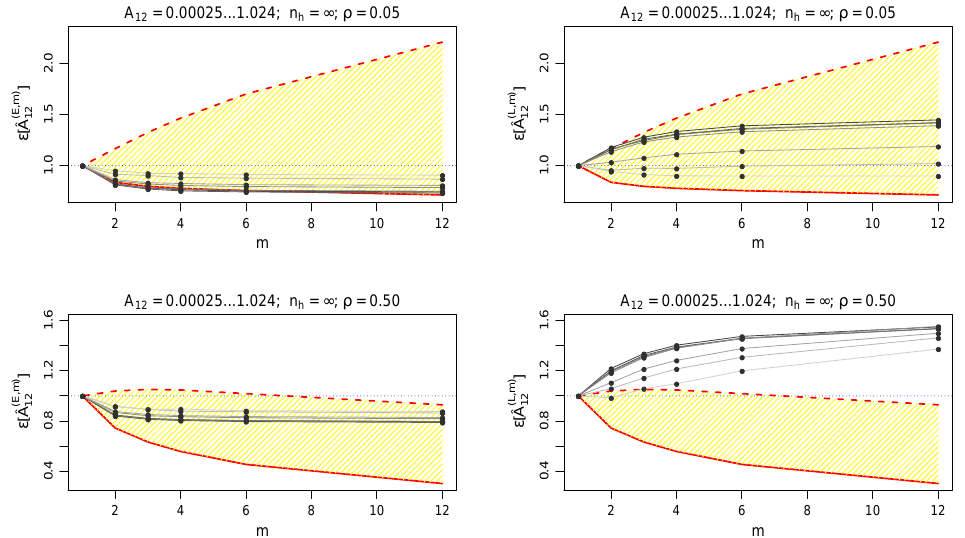
] (exact— left panels) and ε [ ˆ A ( L , m ) ] (2nd 12 12